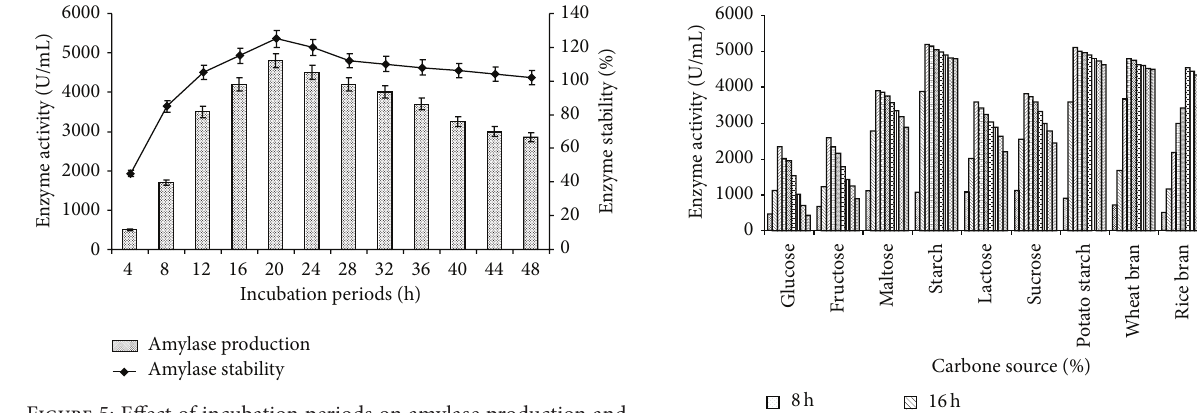
Figure 5: Effect of incubation periods on amylase production and stability. The flasks were inoculated with culture and were incubated at different incubation periods (4–48 h) at initial pH 7.0, 55 ∘ C. For enzyme activity, the reaction was assayed at respective incubation periods and for stability enzyme was preincubated for 4–48 h at 55 ∘ C for 1h and assayed by standard assay method. Error bars presented mean values of ± standard deviation of triplicates of three independent experiments.